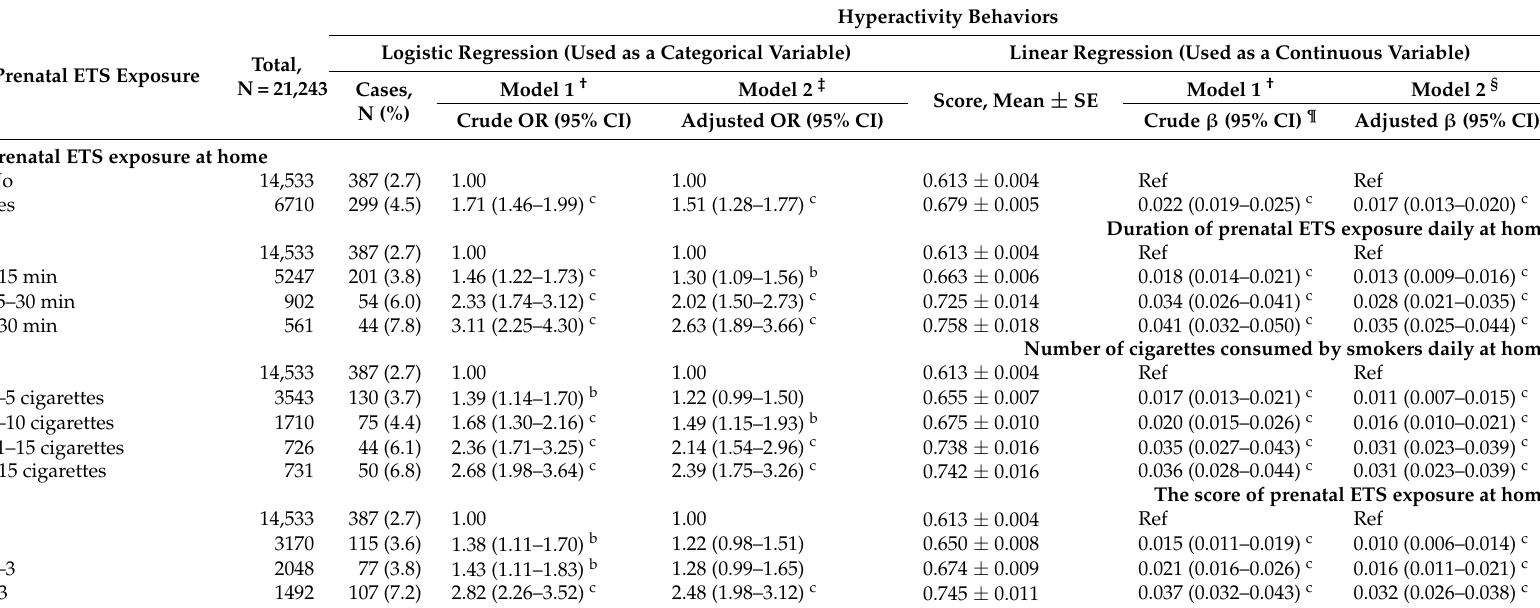
Table 2. Results from logistic and linear regression models on the association between prenatal environmental tobacco smoke (ETS) exposure and hyperactivity behaviors in young